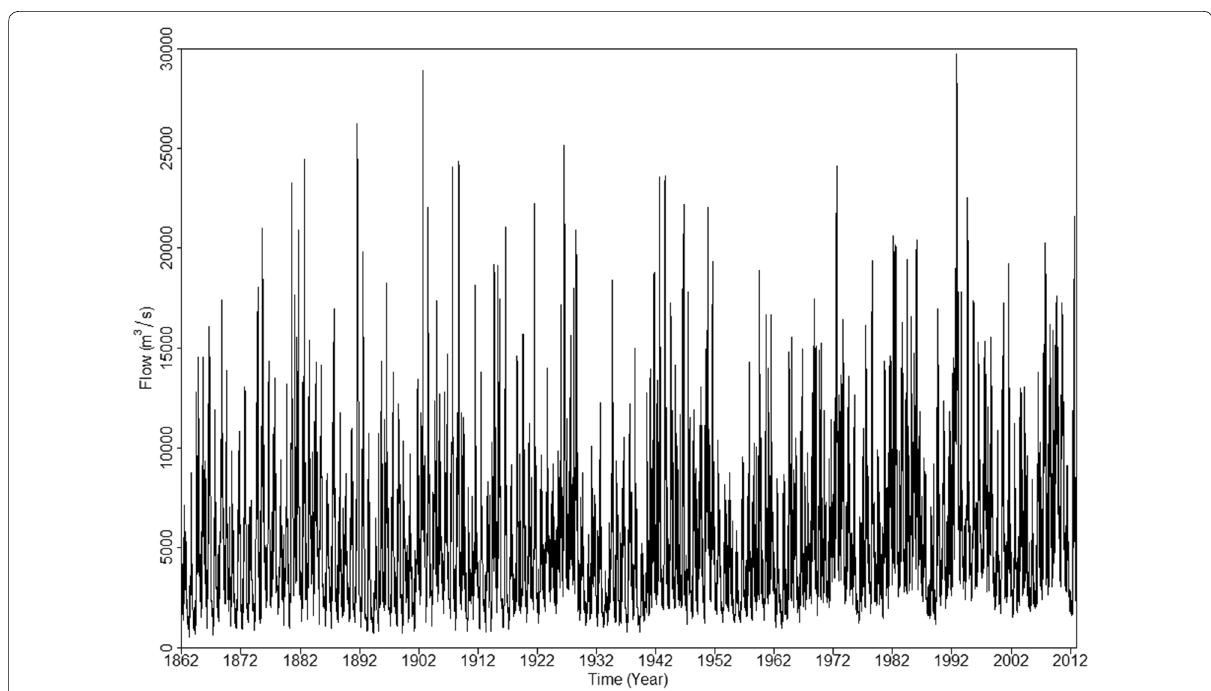
Fig. 4 Variation of daily streamflow time series from the Mississippi River basin at St. Louis, Missouri,